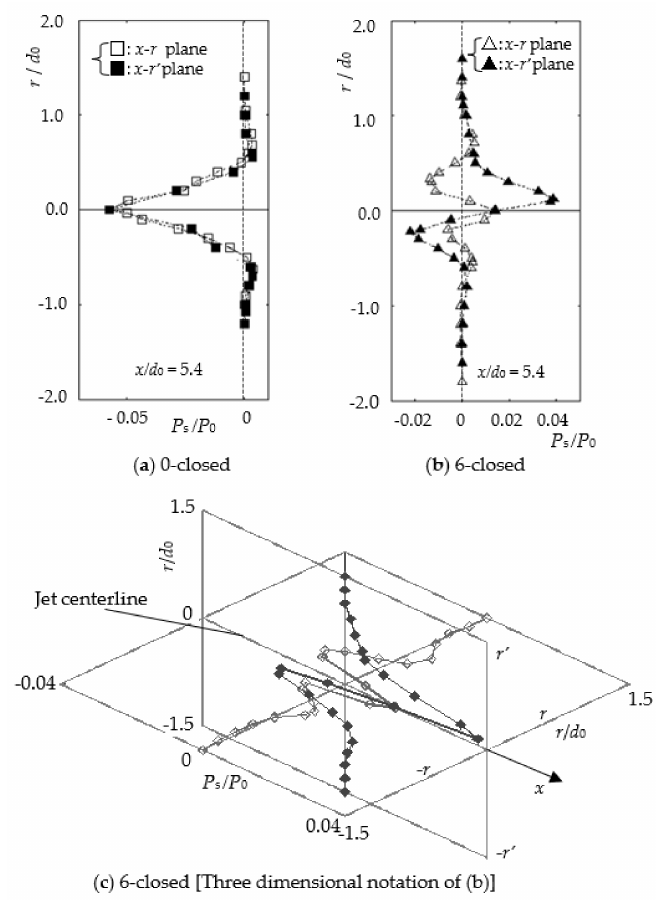
Figure 7. Static pressure distribution, P s / P 0 , in the cross section at x / d 0 = 5.4 ( P 0 = 0.38 MPa): The jet reattaches to the wall of the Co-nozzle at the + r’ − axis side and entrains the surrounding fluid from the – r’ -axis side of the negative pressure.